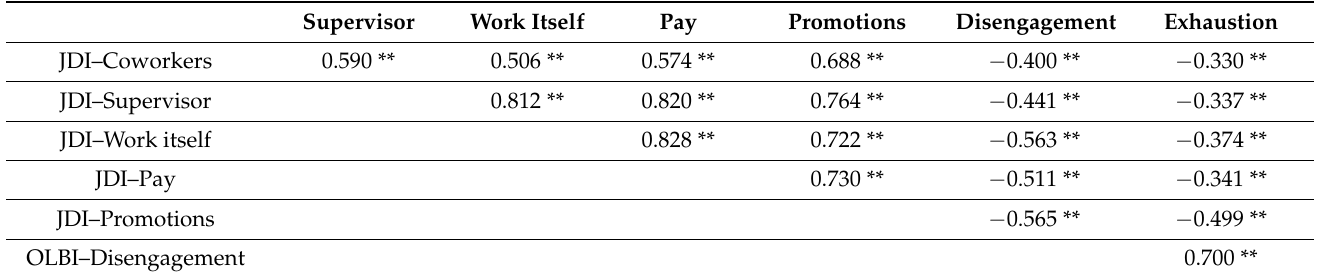
Table 4. The Spearman correlations between JDI and OLBI results (N = 404).